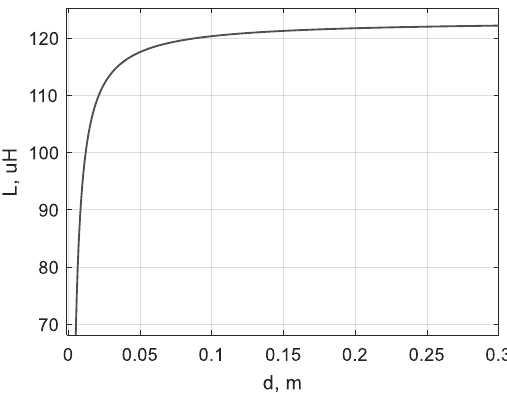
online tool; ( b ) etched and soldered coil. Actual size: 90 × 90 mm, inductance 120 μ H.